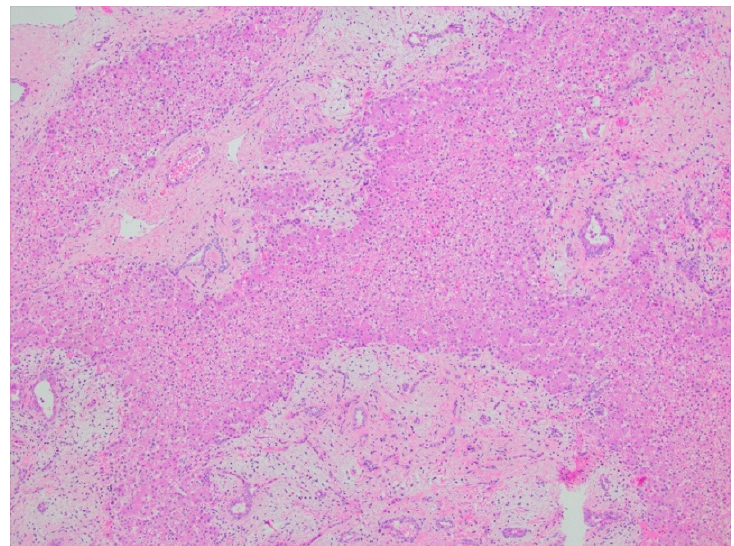
Figure 4. Mesenchymal hamartoma (H&E, 4× magnification). Mixture of epithelial and stromal elements, with interspersed hepatic parenchyma. The epithelial component consists of disorganized bland ductal structures, and the stromal component includes spindle cells, set in a loose myxoid background.